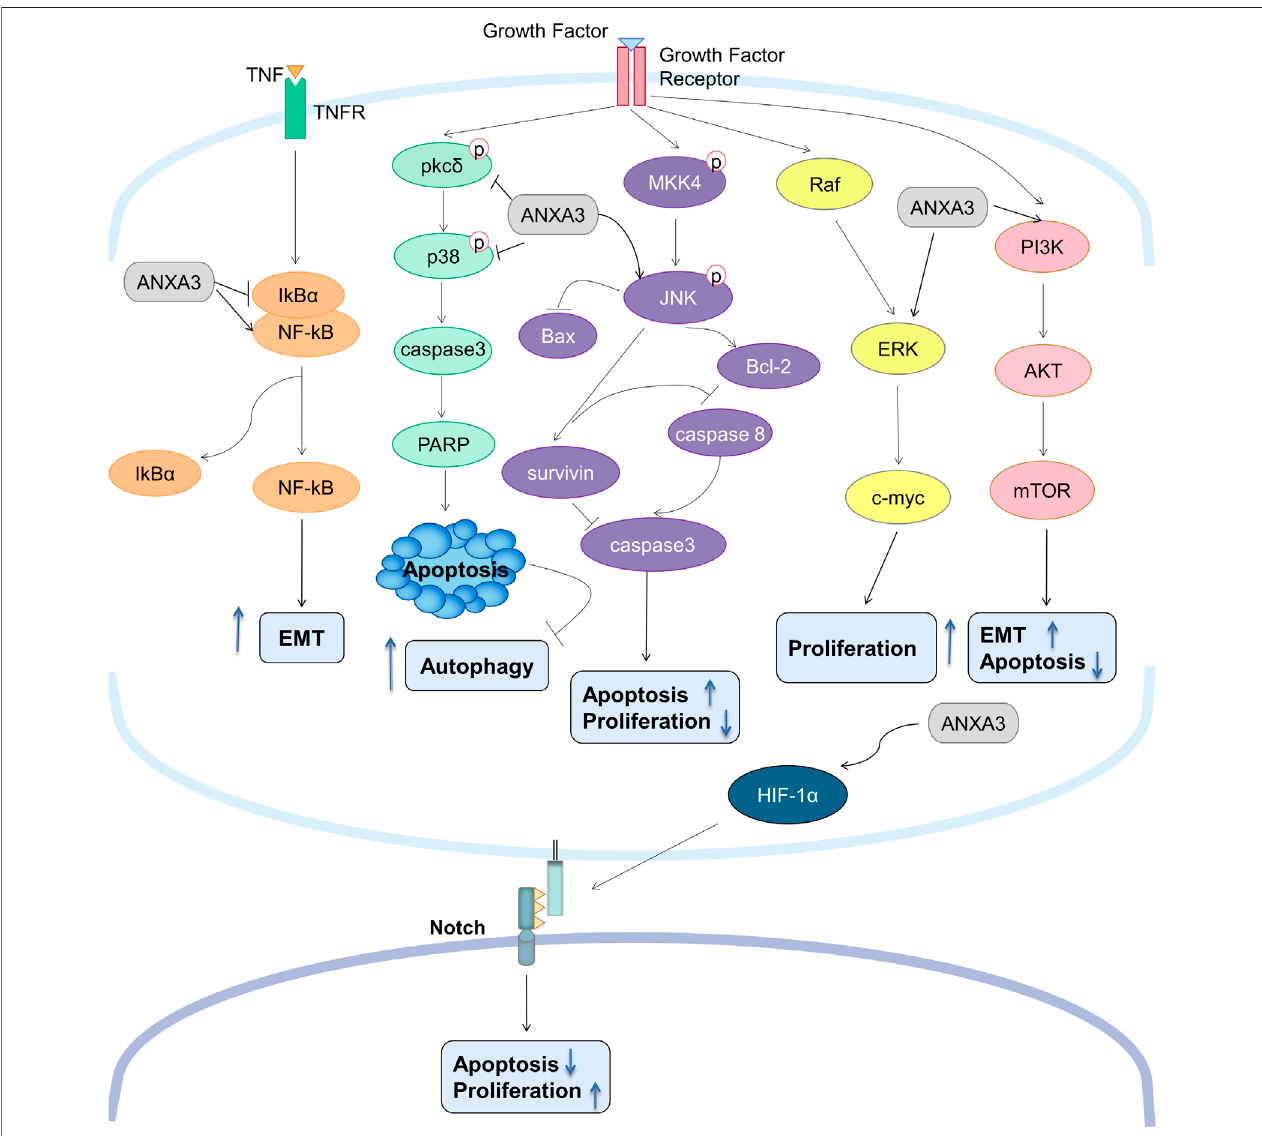
FIGURE2| OverviewofthesignaltransductionnetworkofANXA3intumors.ANXA3promotestumorigenesis via :(1)activatingNFkBpathwayleadingtoincreased EMT; (2) inhibiting PKC δ /p38 pathway leading to decreased apoptosis and increased autophagy; (3) activating JNK/survivin and Raf/ERK/c-myc pathways leading to increased proliferation; (4) activating PI3K/Akt/mTOR pathway leading to increased EMT and decreased apoptosis; and (5) activating HIF-1 α /Notch pathway leading to increased proliferation and decreased apoptosis. p38, p38 mitogen-activated protein kinases; PARP, Poly (ADP-ribose) polymerase; bax, Bcl-2-associated X protein; bcl-2, B-cell lymphoma 2; I κ B α , nuclear factor of kappa light polypeptide gene enhancer in B-cells inhibitor, alpha; NF- κ B, nuclear factor kappa-light-chain- enhancer of activated B cells; HIF-1 α , Hypoxia-inducible factor 1-alpha; EMT, Epithelial-Mesenchymal Transition; TNF, Tumor necrosis factor.